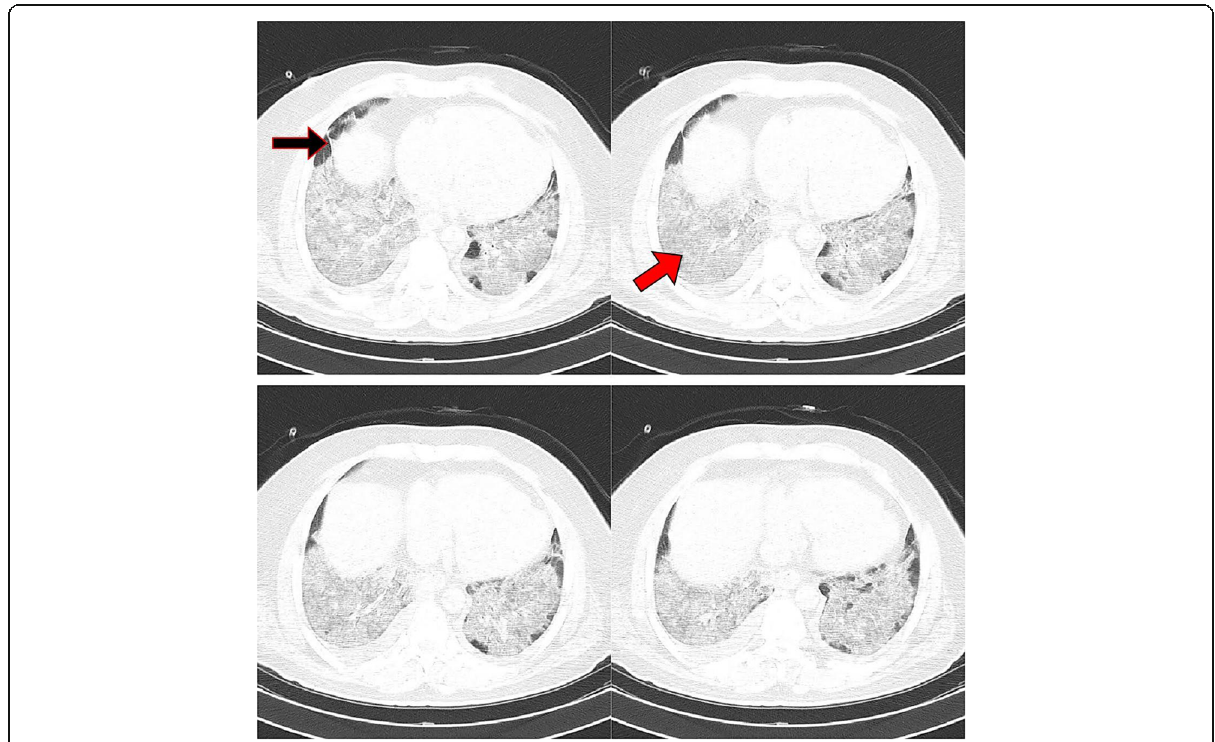
Fig. 3 A 62-year-old male patient presented with fever, chills, myalgia, headache, and sputum discharge, who was admitted to ICU for 2 days and died. Extensive multilobar ground glass opacity and consolidation (red arrow), and parenchymal bands (black arrow) are observed in the CT scan, suggesting acute respiratory distress syndrome. The total CT severity score was calculated as 25, and the disease severity was